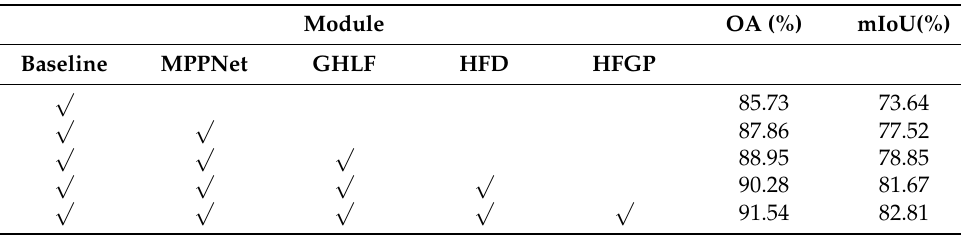
Table 3. Quantitative evaluation of ablation studies on the Vaihingen dataset.